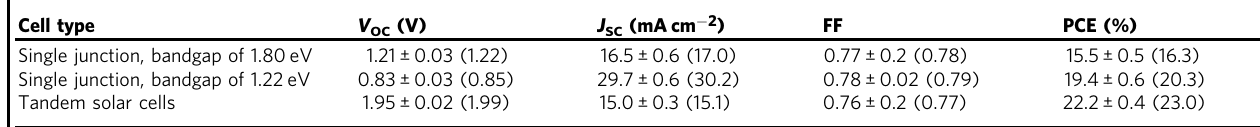
Table 2 J – V characteristics of individual WBG and NBG single-junction PSCs and their tandem solar cells measured under AM1.5 illumination Cell type Single junction, bandgap of 1.80